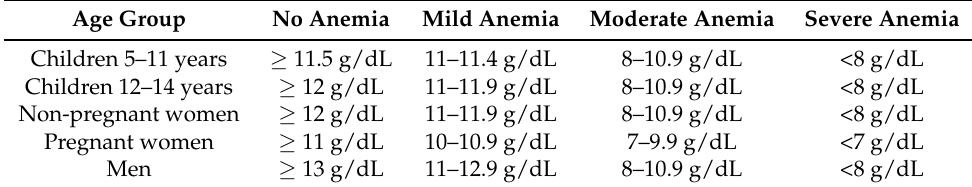
Table 1. Hemoglobin (Hb) thresholds used to define anemia living at sea level according to the World Health Organization guidelines